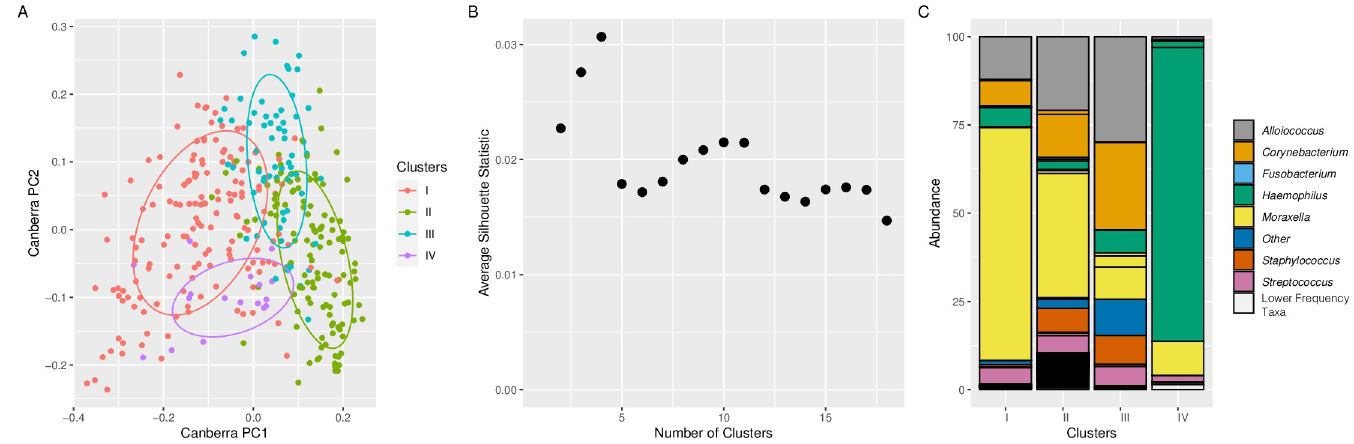
Fig 1. Compositionally distinct nasopharyngeal microbiota are evident in longitudinally collected pediatric samples. A. Four distinct microbiota assemblages are evident in nasopharyngeal samples of pediatric subjects [ANOVA(LME) P < 0.001, Canberra]. B. Average silhouette statistic supports the observation that a four- cluster solution best fits the model (greatest average silhouette statistic). C. Stacked bar plot of taxa from each cluster indicates that distinct bacterial distributions dominate each of the four nasopharyngeal microbiota. Each box represents a unique taxon within the cluster. Colors represent the genus-level identity of the taxon; white indicates lower frequency taxa.